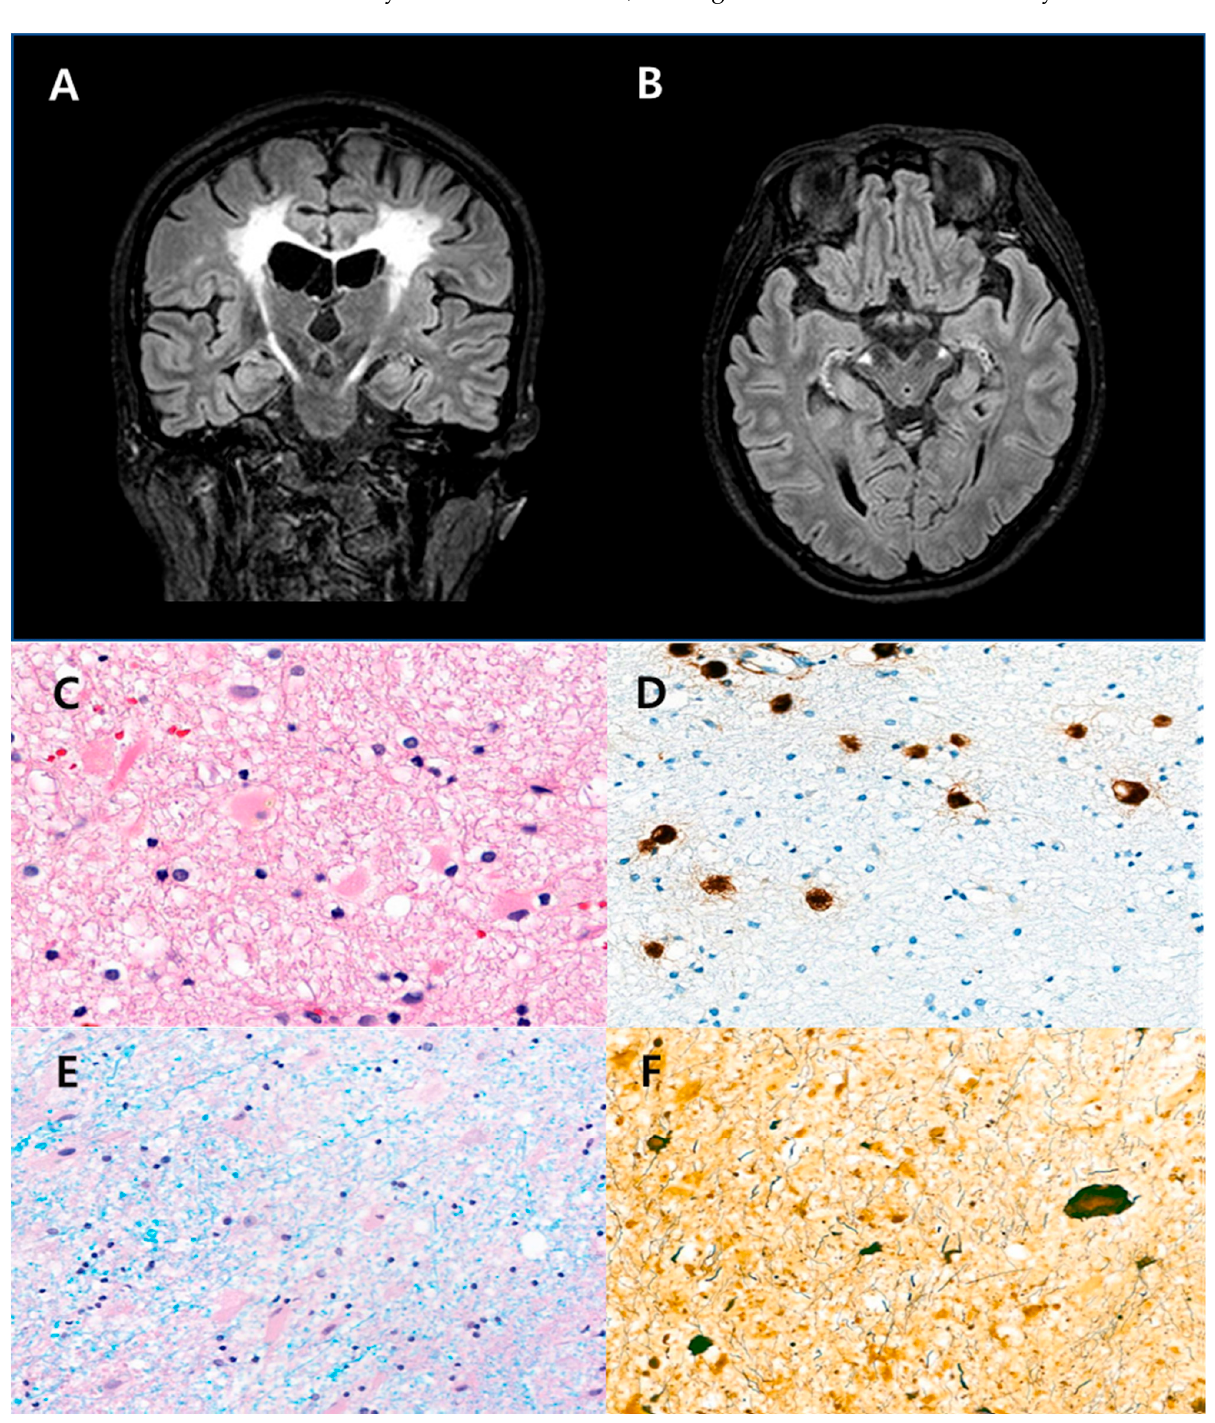
Figure 4. Brain magnetic resonance imaging (MRI) and histopathological findings of case 3. ( A , B ) Brain MRI (FLAIR sequence) revealed multifocal high-signal intensities in the bilateral corona radiata and corticospinal tracts. ( C ) There were frequent eosinophilic spheroids